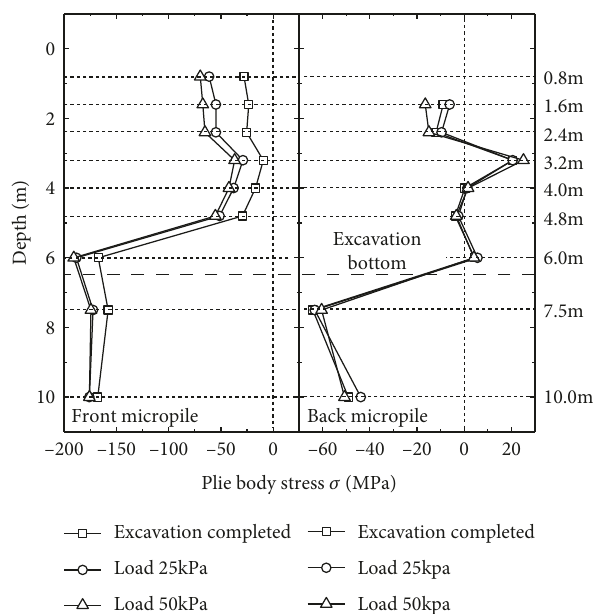
Figure 11: Stress distribution of steel pipe pile before and after loading.